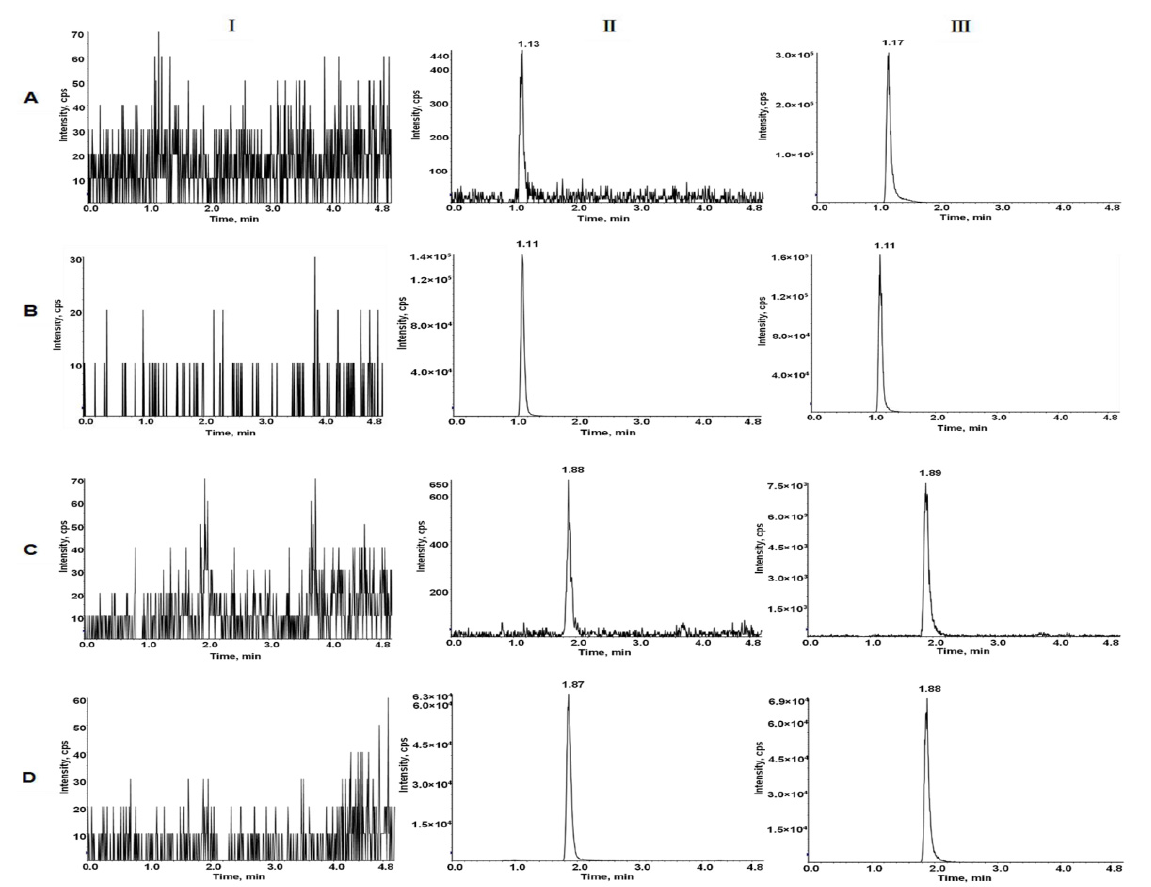
Figure 3. Typical MRM chromatograms of LEN ( A ), 2 H 5 -LEN ( B ), TEL ( C ), and TEL-d 3 ( D ). I, blank plasma; II, blank rat plasma spiked with the mixed working solution at LLOQ level and IS; III, rat plasma sample after oral administration of LEN and TEL.